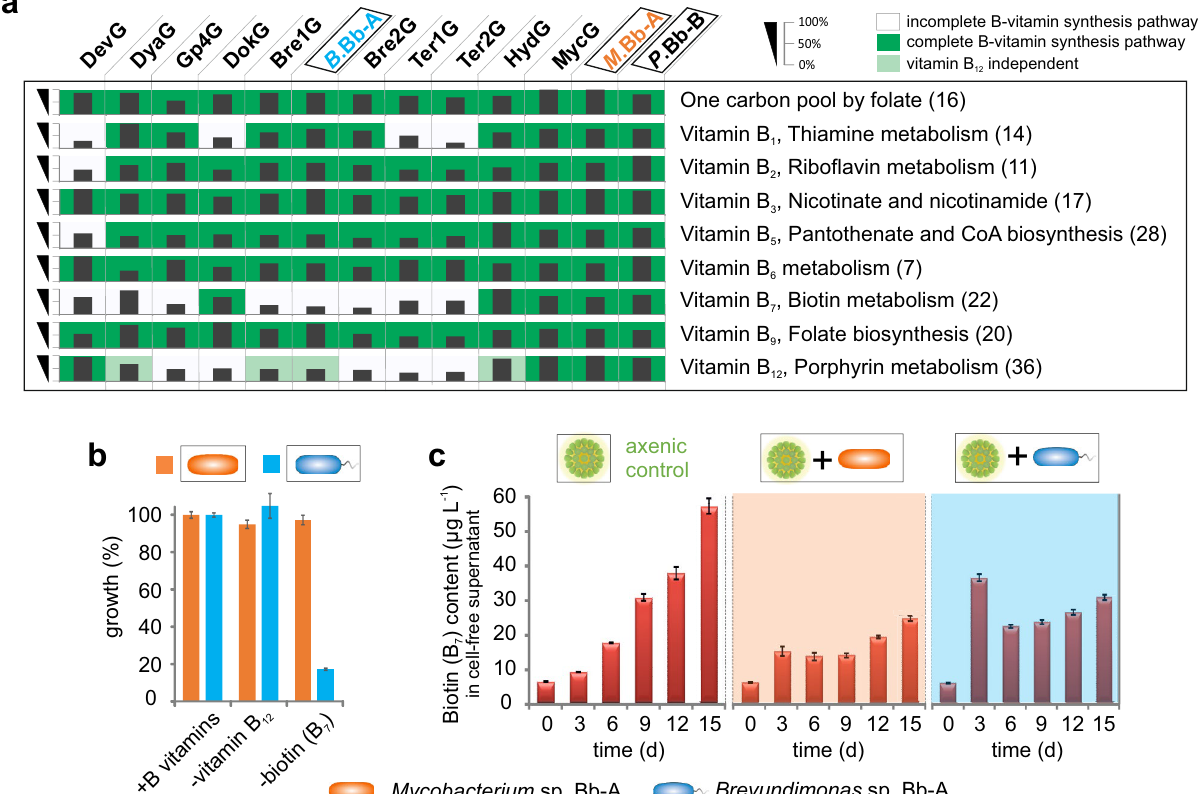
Figure 3. Essential cofactors (inter-)dependencies of the bacterial core community and isolates of B. braunii . ( a ) Heatmap of the reconstructed de novo biosynthesis of B-vitamins encoded in the high-quality draft and complete bacterial genomes. Numbers in parentheses represent the maximal total number of genes within each pathway. Percentage: per cent of total number of genes per pathway identified within each genome. All annotated genes within the respective pathways are presented on the EMGB platform (https ://emgb.cebit ec.uni-biele feld.de/Bbrau nii-bacte rial-conso rtium /). The pathways statistics are summarized in the Table S5 and S8. ( b ) Growth assay to confirm B-vitamin auxotrophy and prototrophy in axenic Brevundimonas sp. Bb-A (blue) and Mycobacterium sp. Bb-A (orange) strains, respectively. ( c ) Biotin concentration levels detected in cell-free supernatants from the cultures of axenic B. braunii as well as in the presence of Mycobacterium sp. Bb-A (orange) and Brevundimonas sp. Bb-A (blue). The error bars represent standard error of mean values of three biological and three technical replicates (SE; n =